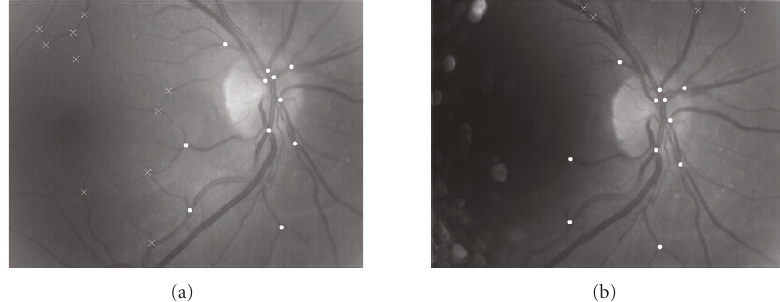
Figure 11: Example of matching between two samples from the same individual in VARIA database. White circles mark the matched points between both images while crosses mark the unmatched points. In (b) the illumination conditions of the image lead to miss some features from left region of the image. Therefore, a small amount of detected feature points is obtained capping the total amount of matched